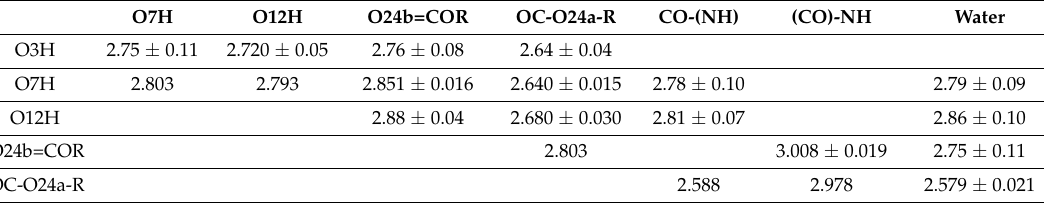
Table 8. Mean values with standard deviations for the donor/acceptor distance in the indicated hydrogen bonds of the monomers indicated in the text. Units of all data in